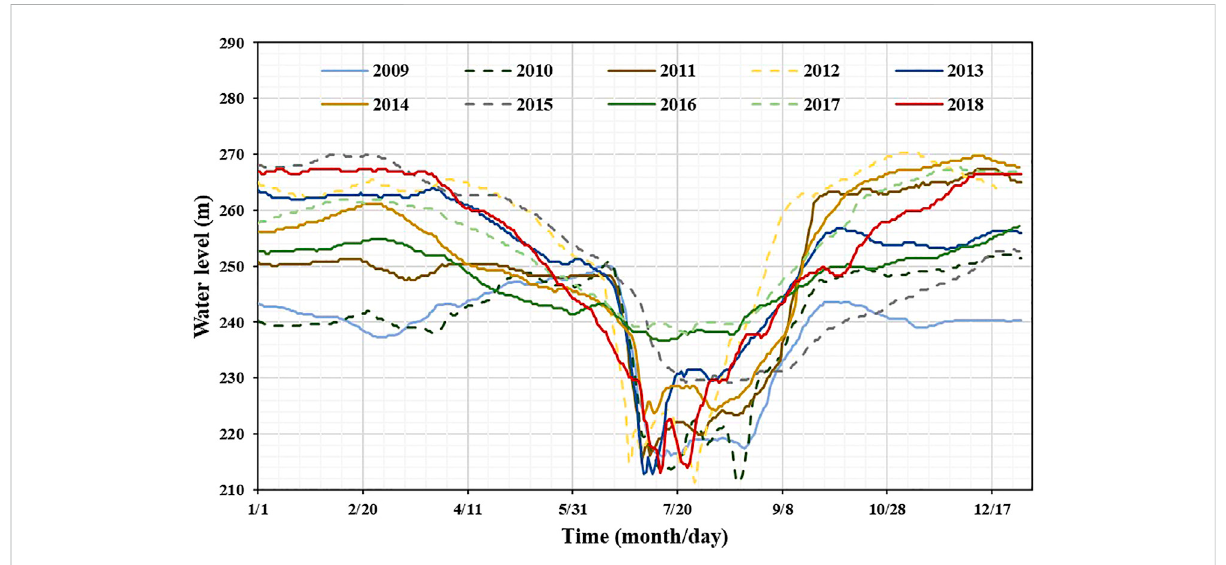
FIGURE 9 Water level of the Xiaolangdi Reservoir from 2009 to